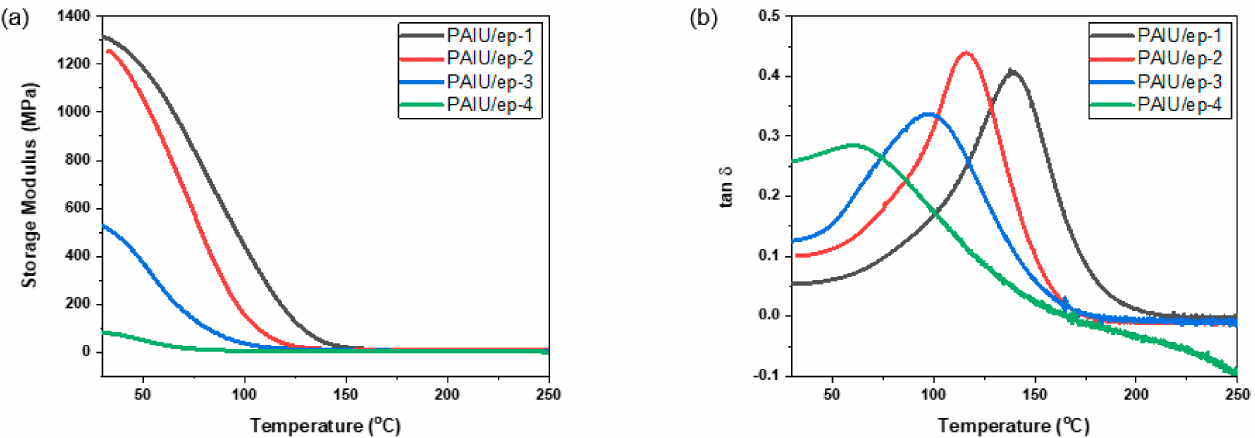
Figure 4. Temperature dependency of ( a ) storage modulus and ( b ) tan δ of PAIU/epoxy IPNs.